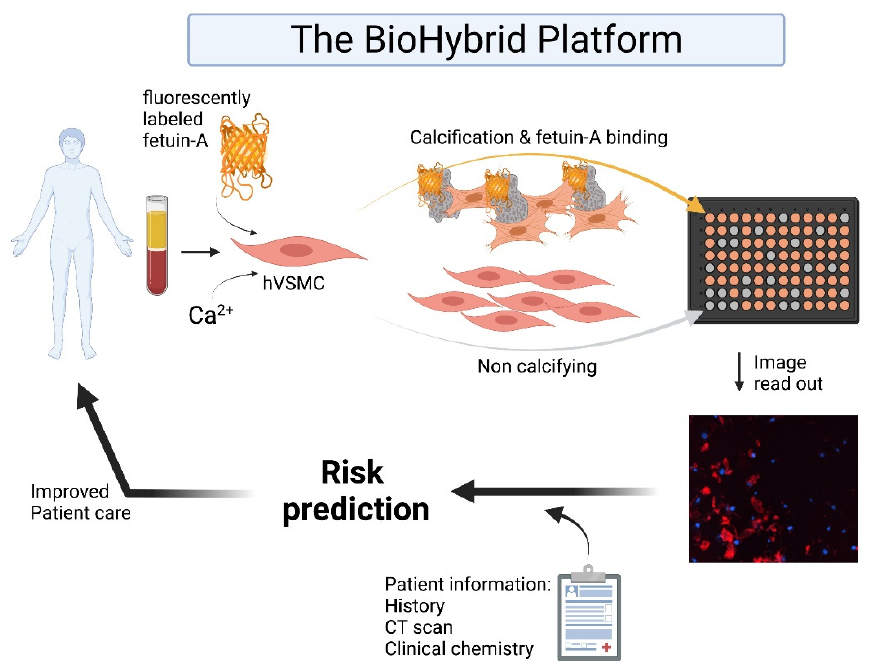
Figure 5. The BioHybrid platform. hVSMC mediated calcification is measured by fluorescent imaging using fetuin-A-AlexaFluor ® -546. Created with BioRender.com. Supplementary Materials: The following are available online at www.mdpi.com/xxx/s1, Figure S1: Validation of the BioHybrid assay, Figure S2: Characterisation of hVSMCs.